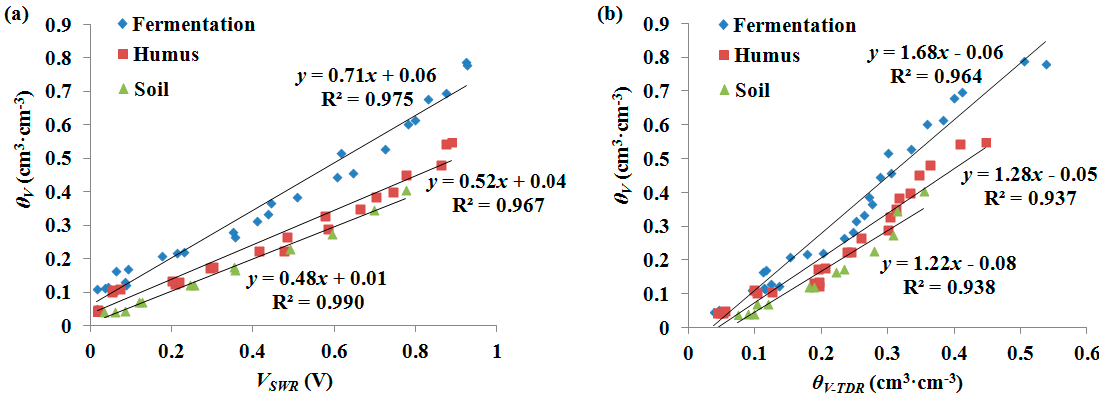
Figure 7. Comparison of volumetric water content determined gravimetrically ( θ V ) vs. ( a ) SWR output voltage ( V SWR ) and ( b ) TDR measured volumetric water content ( θ V-TDR ) between fermentation, humus and soil.